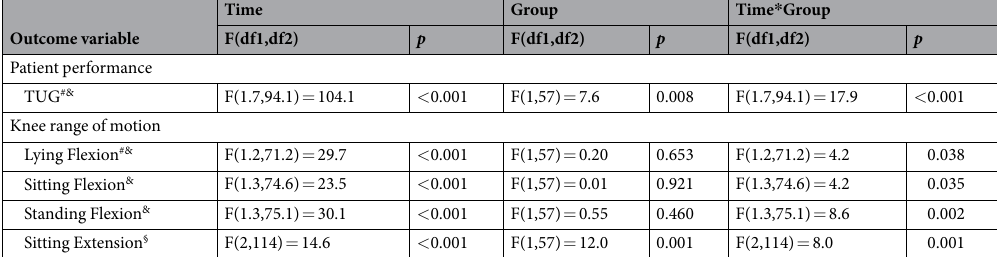
Table 4. Outcomes assessment - Repeated measures analysis. # ln transformation; § sqrt transformation; & Greenhouse-Geisser